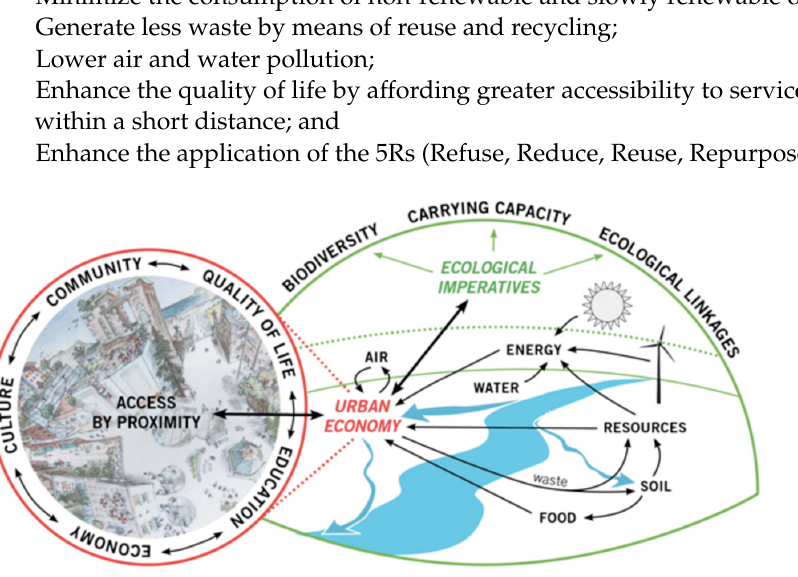
Figure 2. Urban forms as interconnected urban ecosystems. Sourced from IEFS (2014, reprinted with permission from Bibri S.E [39]).